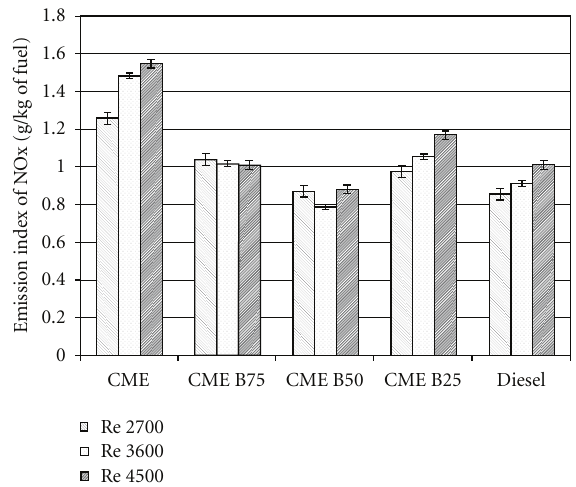
Figure 9: Comparison of NOx emission index of various